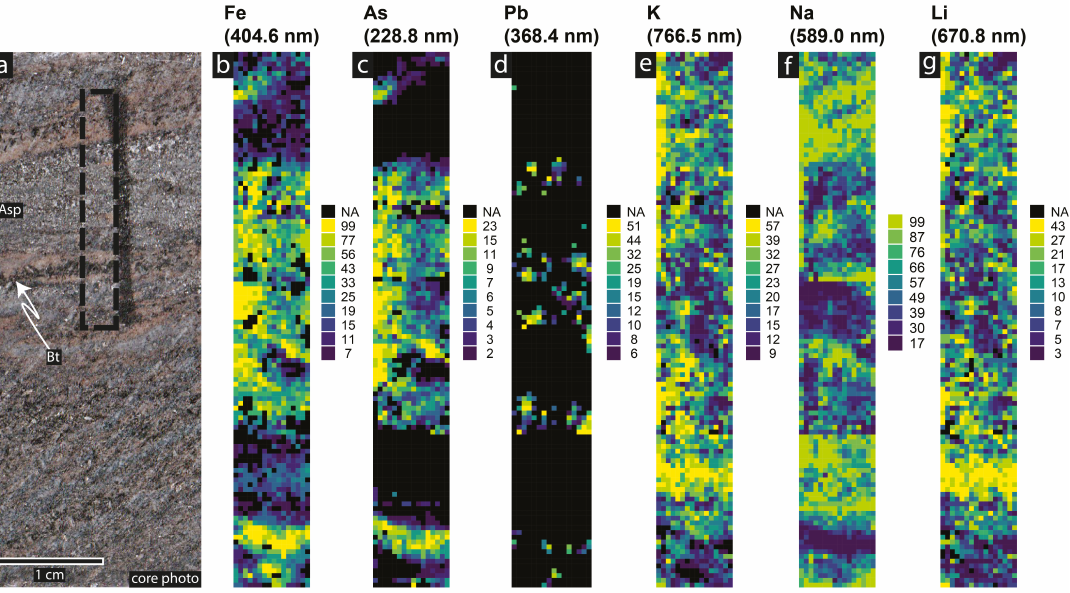
Figure 26. ( a ) Photo of gold- and base metal-rich quartz vein from the MacLellan deposit, Lynn Lake, Manitoba. Mapping area comprises quartz (Qtz), arsenopyrite (Asp), biotite (Bt), muscovite (Mus), and lesser galena (Gl); LIBS mapping results for ( b ) Fe, ( c ) As, ( d ) Pb, ( e ) K, ( f ) Na, and ( g ) Li processed using new R code and displayed as relative wavelength intensities (%). Geochemical imaging is also e ff ective at mapping the distribution of rare galena and the enrichment of light elements along the margins of and within the arsenopyrite-rich vein. Maps were acquired in an Ar environment on the unprepared surface of the cut drill